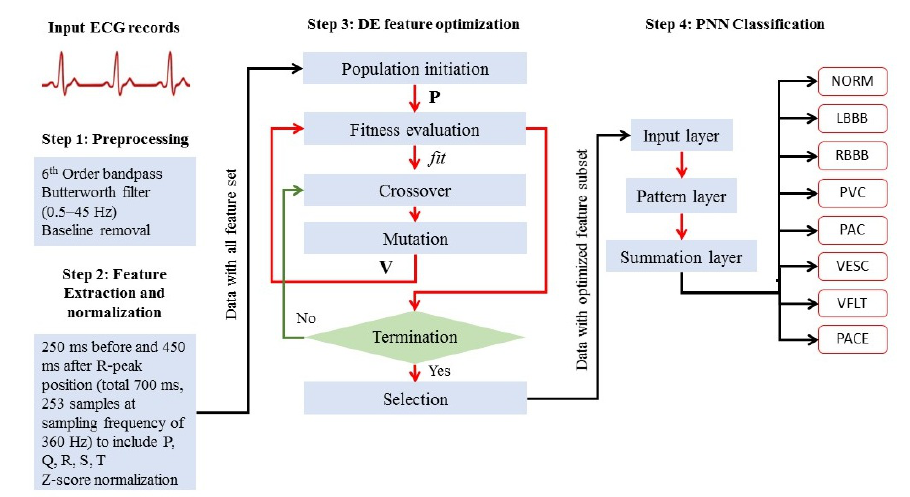
Figure 4. Detailed methodology: Differential Evolution-based feature optimization with Probabilistic Neural Network for imbalanced arrhythmia